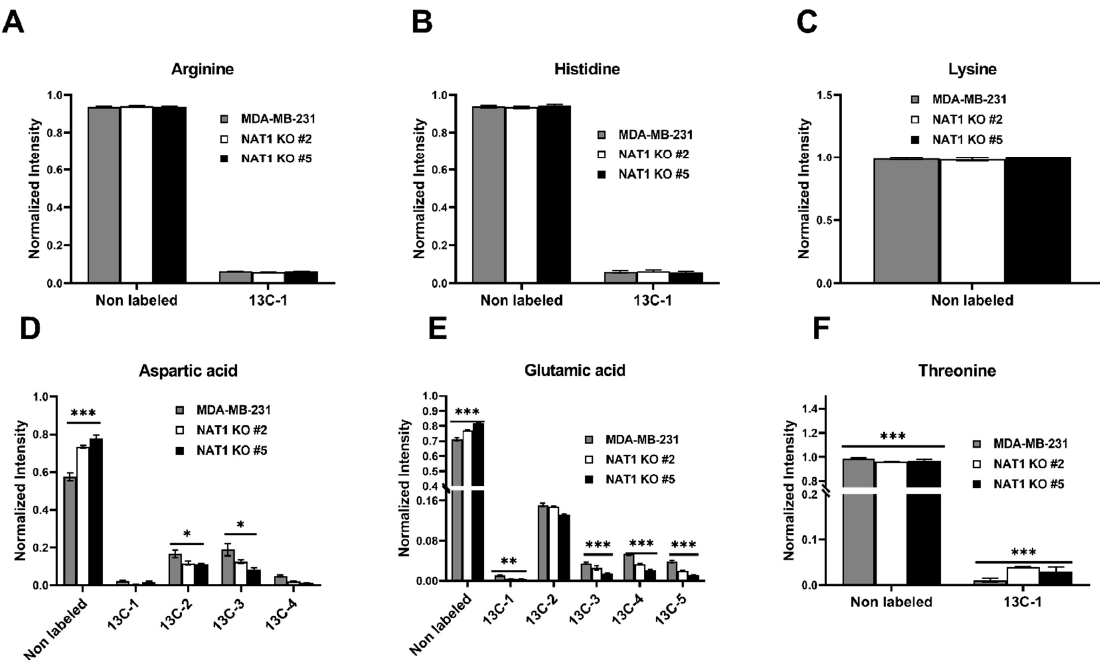
Figure 8. N -Acetyltransferase 1 Knockout Effect on Amino Acid Levels in MDA-MB-231 Cells. Carbon-13 enrichment of charged amino acids were measured in MDA-MB-231 cells and NAT1 KO #2 and #5 after 24 h incubation with [ 13 C]-glucose. Data are presented for both detected unlabeled [ 12 C] and [ 13 C]-labeled metabolites. ( A ) Arginine ( 13 C-1) ( B ) Histidine ( 13 C-1) ( C ) Lysine ( D ) Aspartic Acid ( 13 C-1,-2,-3, and -4) ( E ) Glutamic Acid ( 13 C-1,-2,-3,-4, and -5) ( F ) Threonine ( 13 C-1). Data represent the average of at least three experiments ± SEM, * q < 0.05, ** q < 0.01, and *** q < 0.001 compared to